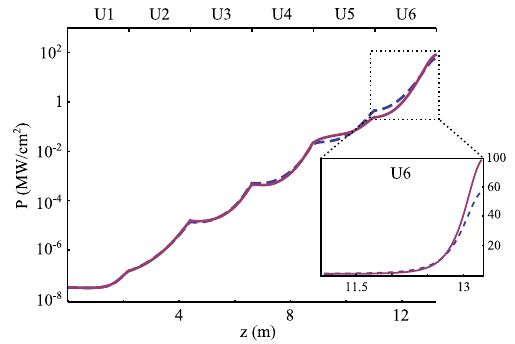
FIG. 5. Simulation of the FEL power growth evolution along the undulator for the matching (blue dashed line) and the transport (red continuous line) options, with the experimental conditions reported in Tables II and III. In the square a detail in linear scale of the evolution in the last undulator section is magnified.